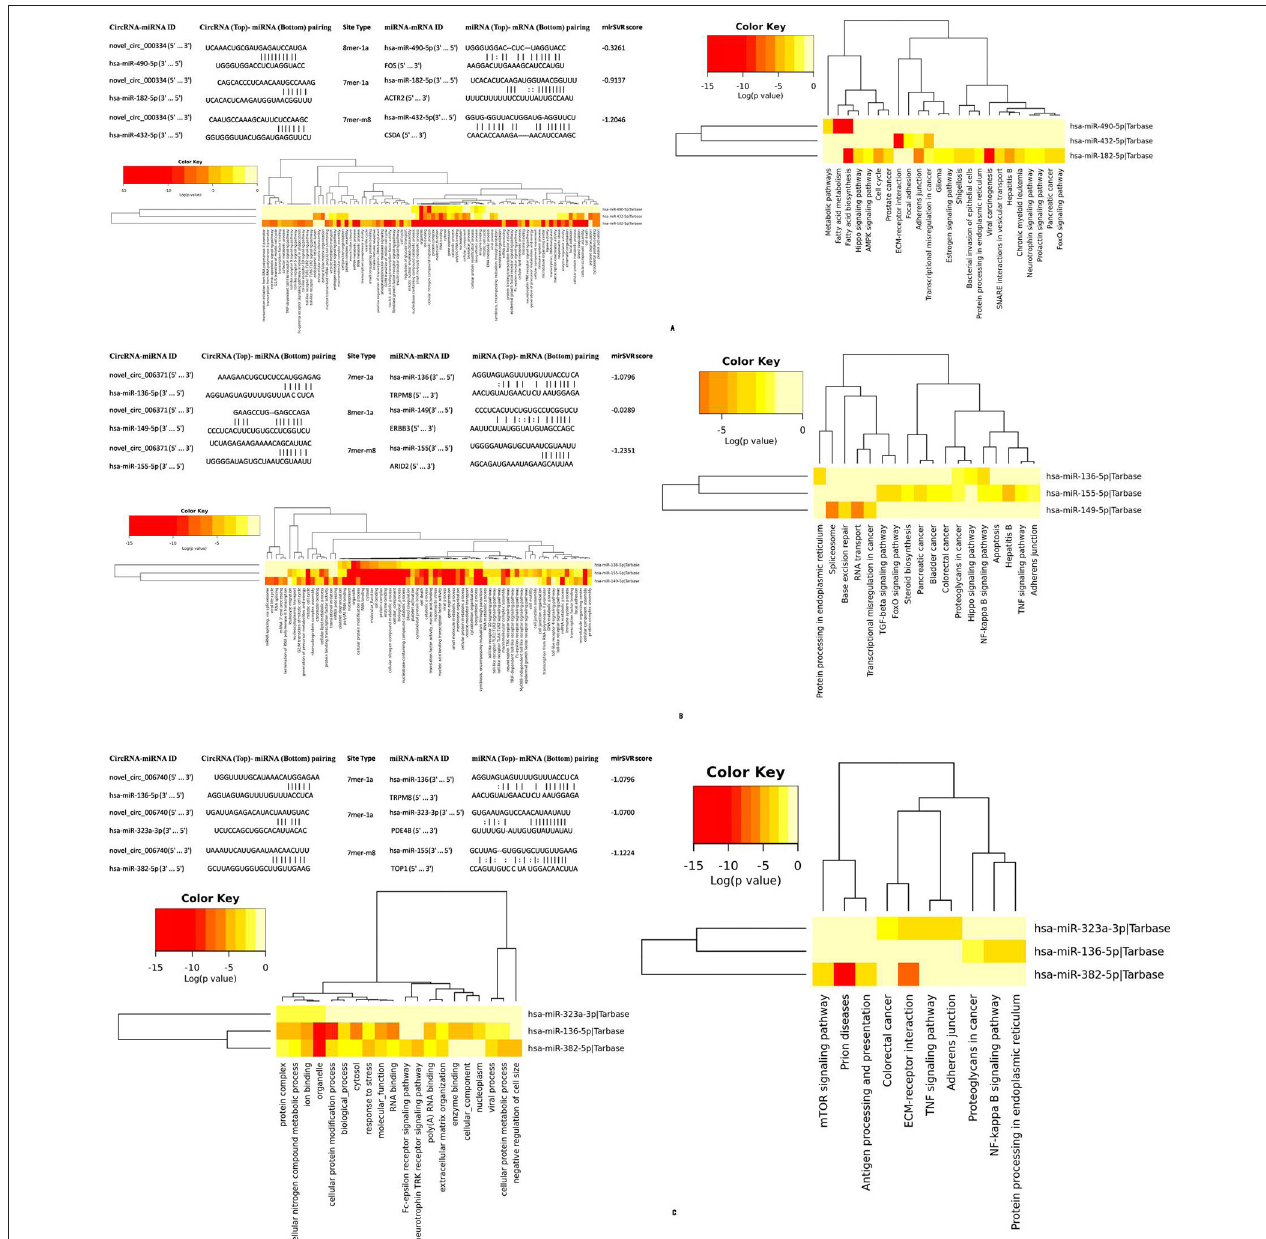
FIGURE 10 | The role of miRNA targeted with circ_000334 (A) , circ_006371 (B) , and circ_006740 (C) by the StarBase and TargetScan databases.